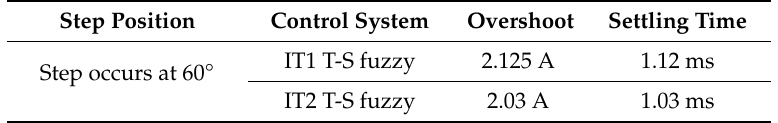
Figure 5. Simulation winding current waveforms by letting i ∗ q = 15 A and i ∗ generator speeds: ( a ) 600 rpm, ( b ) 900 rpm and ( c ) 1200 rpm.